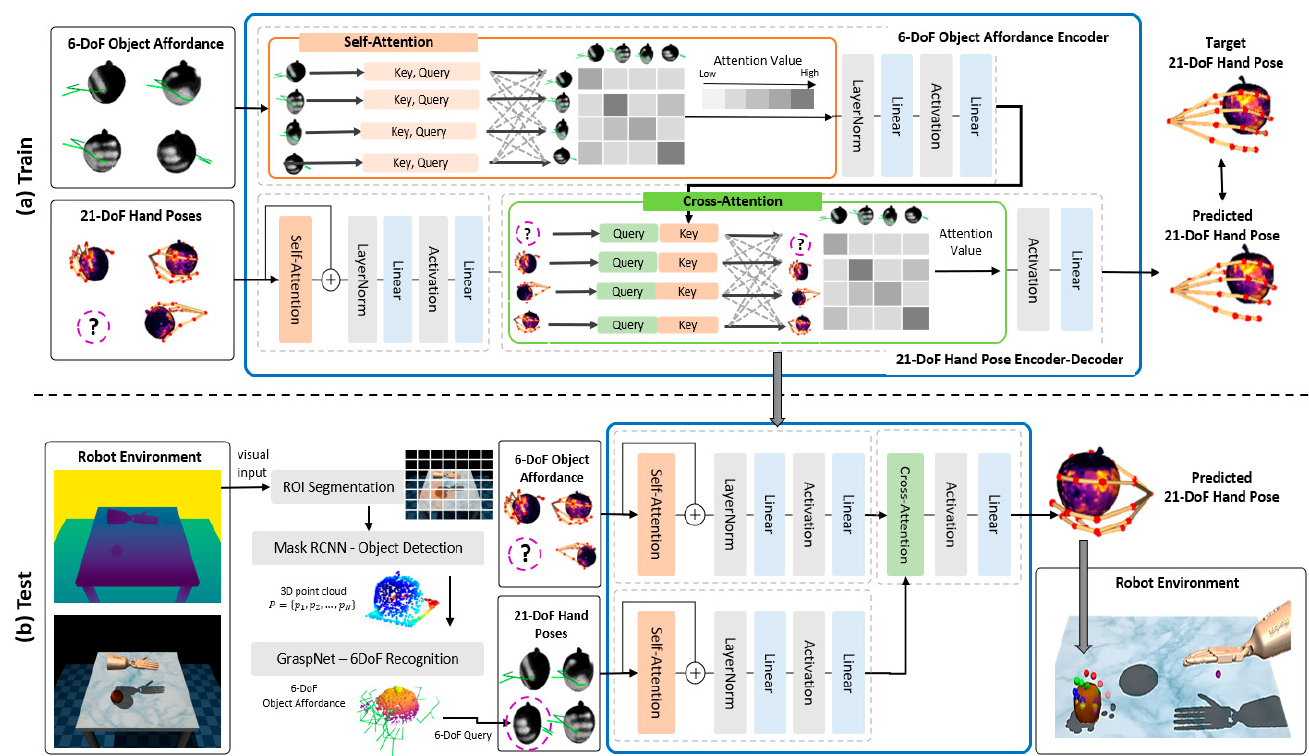
Figure 2. The architecture of the transformer Network. ( a ) In Training, it takes both 6-DoF object affordance and 21-DoF hand pose as input to estimate an optimal 21-DoF hand pose for grasping the object. ( b ) At test time, 6-DoF object affordance is generated through GraspNet from an RGB-D image taken in the environment. Then, the trained transformer network estimates the optimal hand pose for generated object affordance.